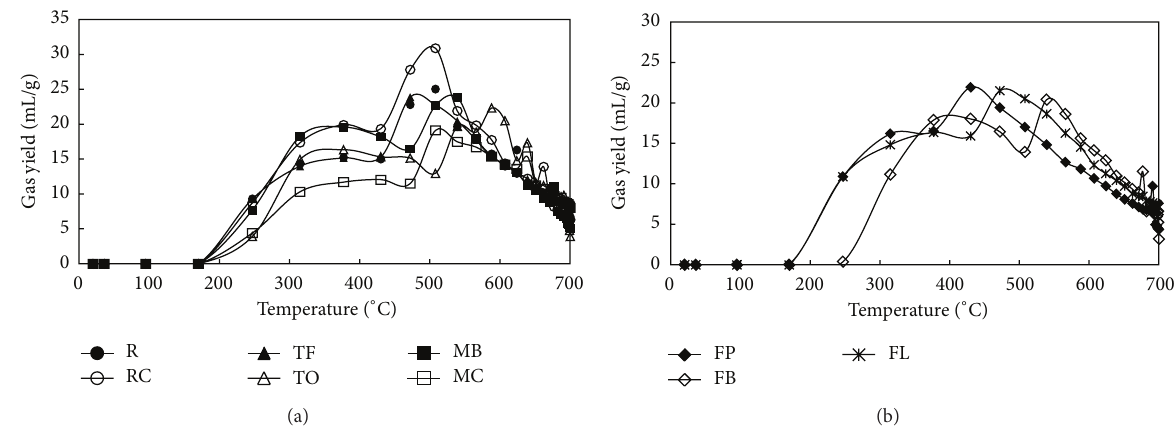
Figure 3: Evolution of gas released during pyrolysis of composts: (a) NHG and (b) HG as a function of temperature.